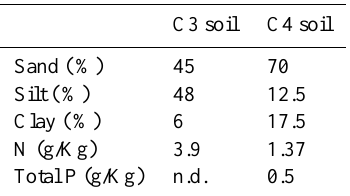
Table 2. Texture and nutrient content of the native soil (C3 soil) and of the soil used for determination of net annual C input (C4